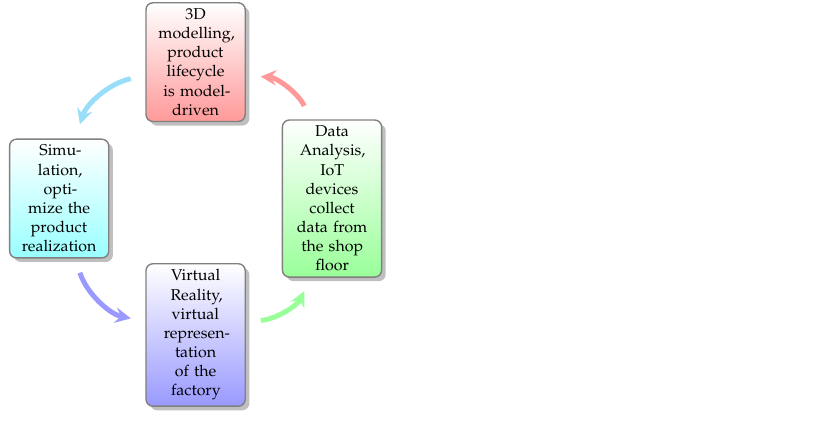
Figure 2. Digital Factory lifecycle. The Smart factory enables data sensing from the shop